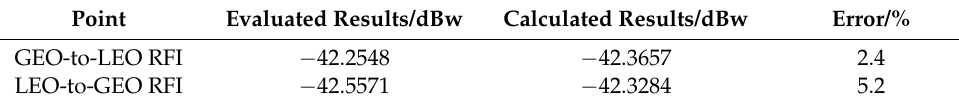
( b ) Figure 7. The relationship between bandwidth and SINR of LEO SARs and GEO SARs images in the presence of scattered wave RFI ( 0 B σ σ= ). The red line indicates that the LEO SAR has the same bandwidth as the GEO SAR, and the invalid value in the yellow box indicates the LEO SAR has the same FM rate as the GEO SAR; ( a ) the integration time is 0.5 s; ( b ) the integration time is 220 s.